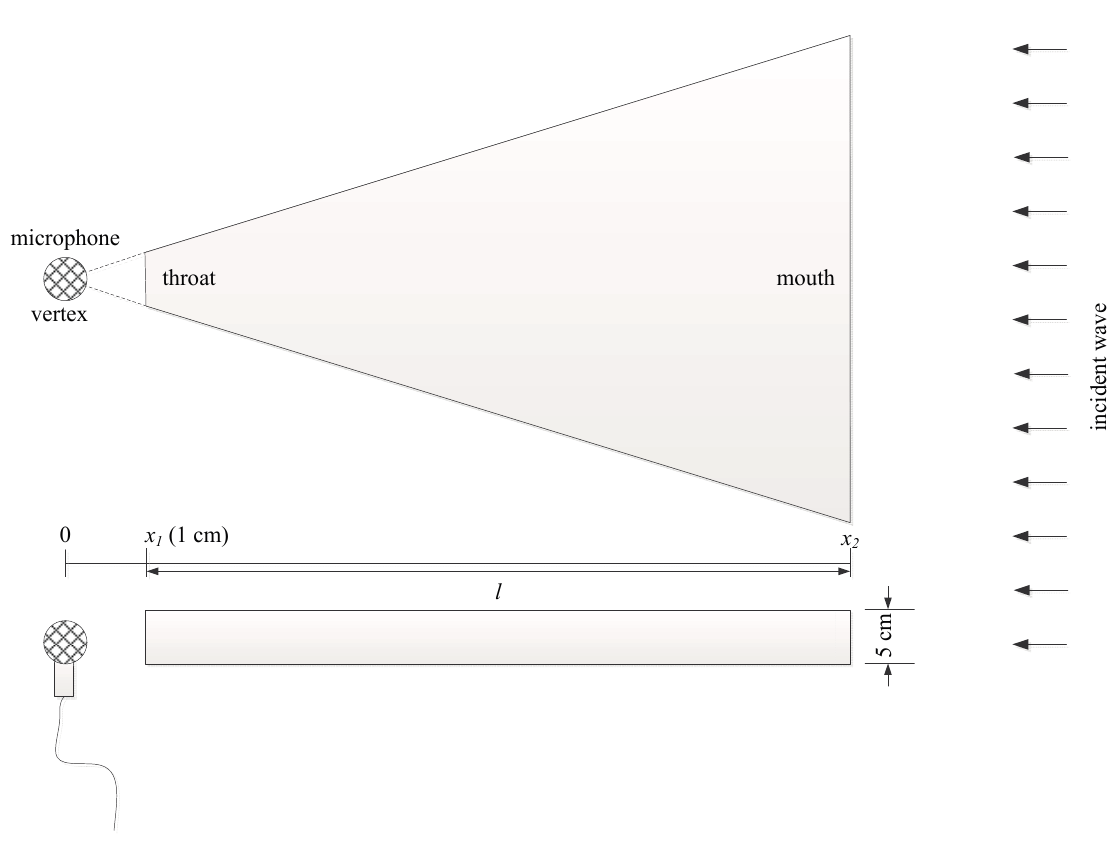
Figure 5. Individual pyramidal horn